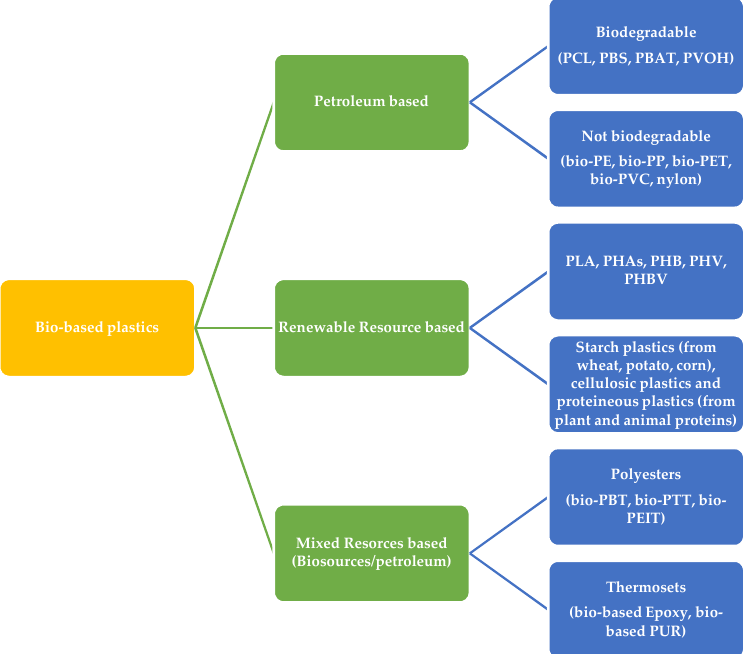
Figure 2. Classification of bio-based plastics.